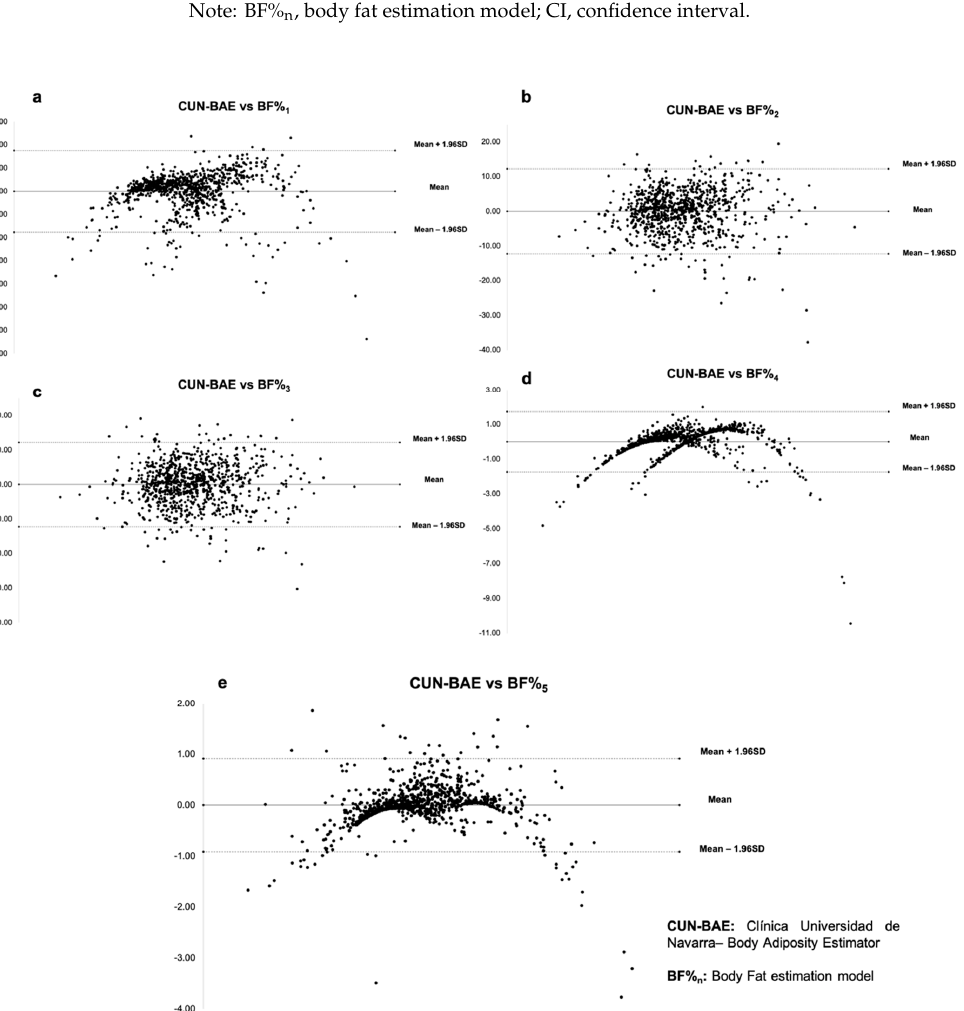
Figure 1. Bland–Altman graphs for body fat estimation models. ( a ) CUN-BAE vs BF% 1 , ( b ) CUN-BAE vs BF% 2 , ( c ) CUN-BAE vs BF% 3 , ( d ) CUN-BAE vs BF% 4 , and ( e ) CUN-BAE vs BF% 5 .